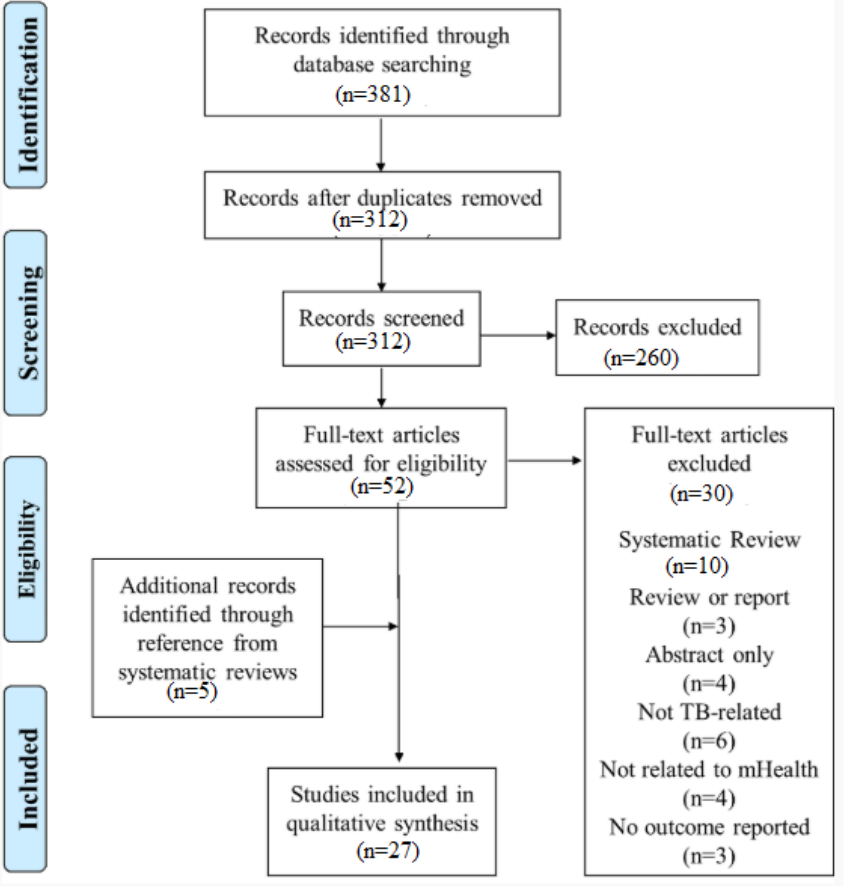
Figure 1. Flow diagram for selection process following the Preferred Reporting Items for Systematic Reviews and Meta-Analyses (PRISMA) guideline. mHealth: mobile health; TB: